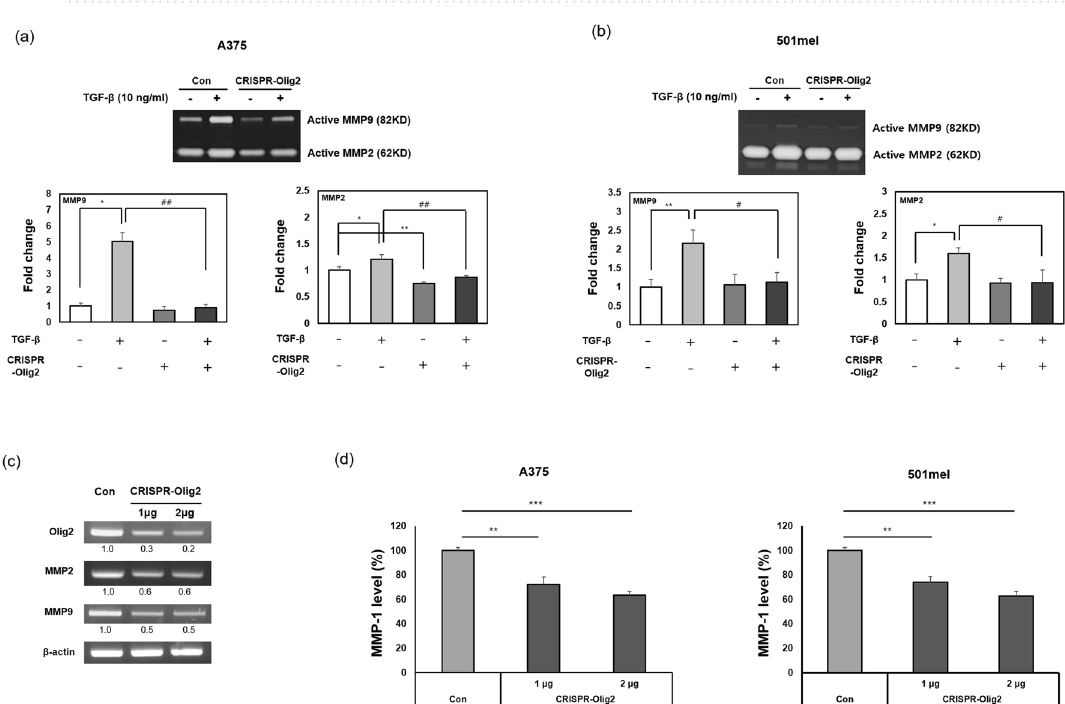
Figure 6. Downregulation of Olig2 decreased MMP-2/-9 activities and MMP-1 expression. Gelatin zymography assay was performed with the conditioned media from ( a ) A375 and ( b ) 501mel cells transfected with negative control (Con) or CRSPR/Cas9-Olig2 plasmid (CRISPR-Olig2) followed by TGF-β (10 ng/ ml) treatment. The fold-change in MMP-2 and MMP-9 activities was assessed by densitometry compared to Con group. The band intensity of MMP-2 and MMP-9 was quantified using NIH ImageJ software. (* p < 0.05; ** p < 0.01versus Con group and # p < 0.05 versus TGF-β group, n = 3). ( c ) MMP-2 and MMP-9 mRNA were evaluated using each primer by RT-PCR. The band intensity was quantified using NIH ImageJ software and normalized relative to β-actin. Original images of gels were provided in supplementary file. ( d ) The concentration of MMP-1 was measured by ELISA using the supernatant of two melanoma cells. (** p < 0.01; *** p < 0.001 versus Con group, n =